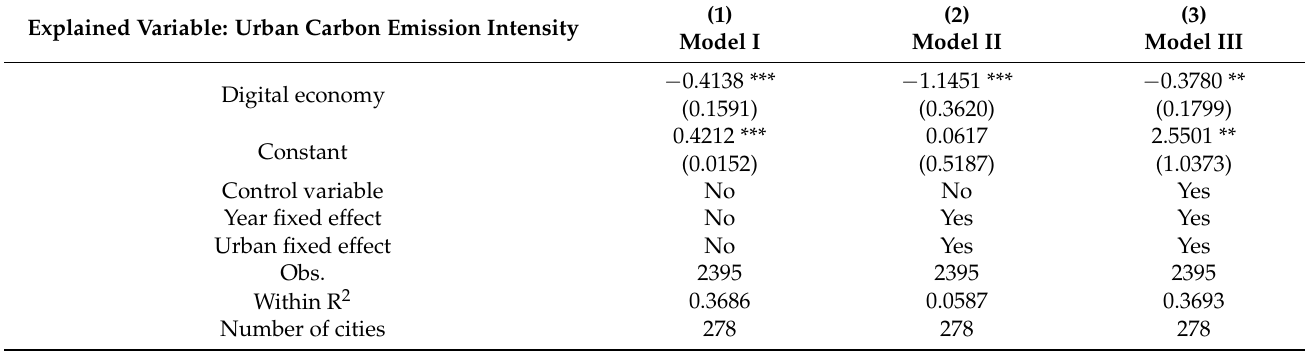
Table 2. Basic regression